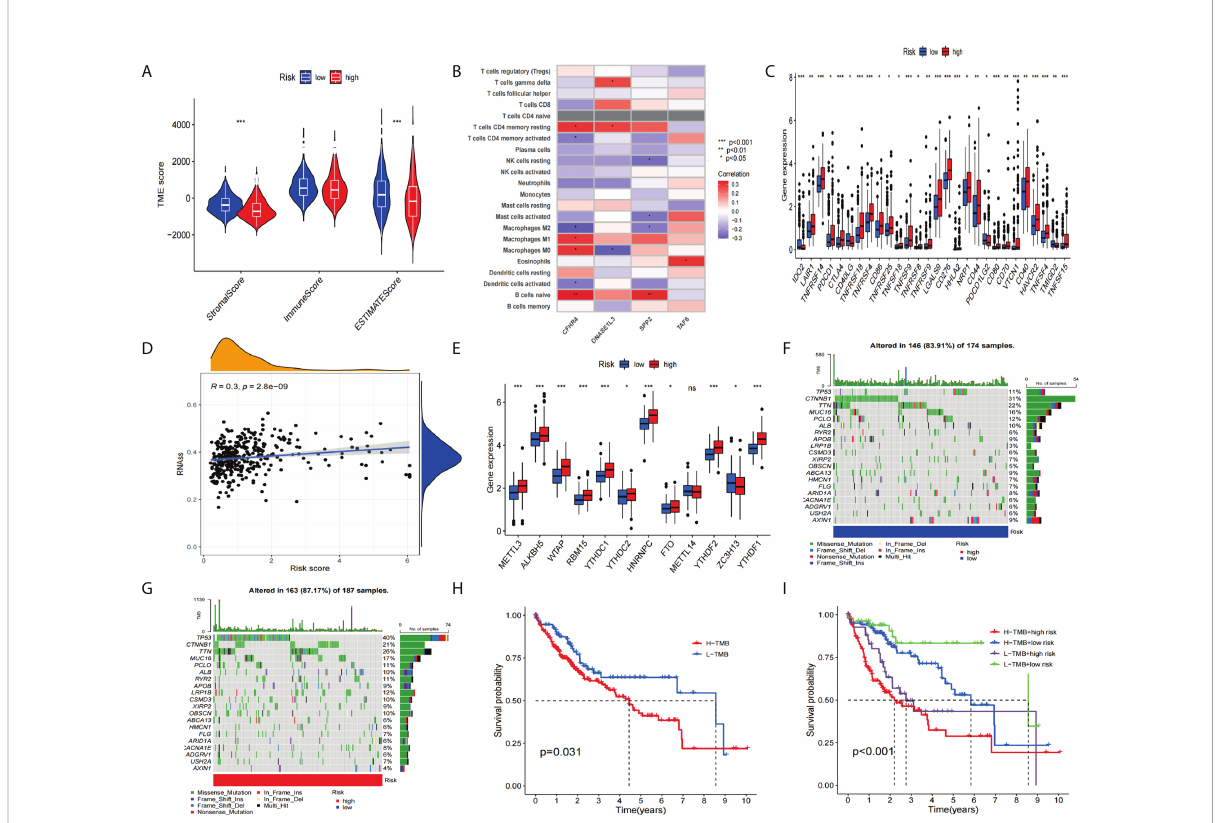
FIGURE 9 To assess the tumor microenvironment, immune checkpoint genes, and tumor mutation burden (TMB) in different groups. (A) Comparison of ESTIMATE scores, stromal scores, and immune scores between the high-risk and low-risk groups. (B) Correlation between the model- constructed genes and immune cells. (C) Differential expression of immune checkpoint genes between the high-risk group and the low-risk groups. (D) Correlation between the stem cell content and the risk score. (E) Differential expression of m6A-related genes (F, G) and the frequency of mutations in the high-risk and low-risk groups. (H, I) The KM curve of the tumor mutation burden versus the OS. *p<0.05, **p<0.01, ***p<0.001; ns, not statistically